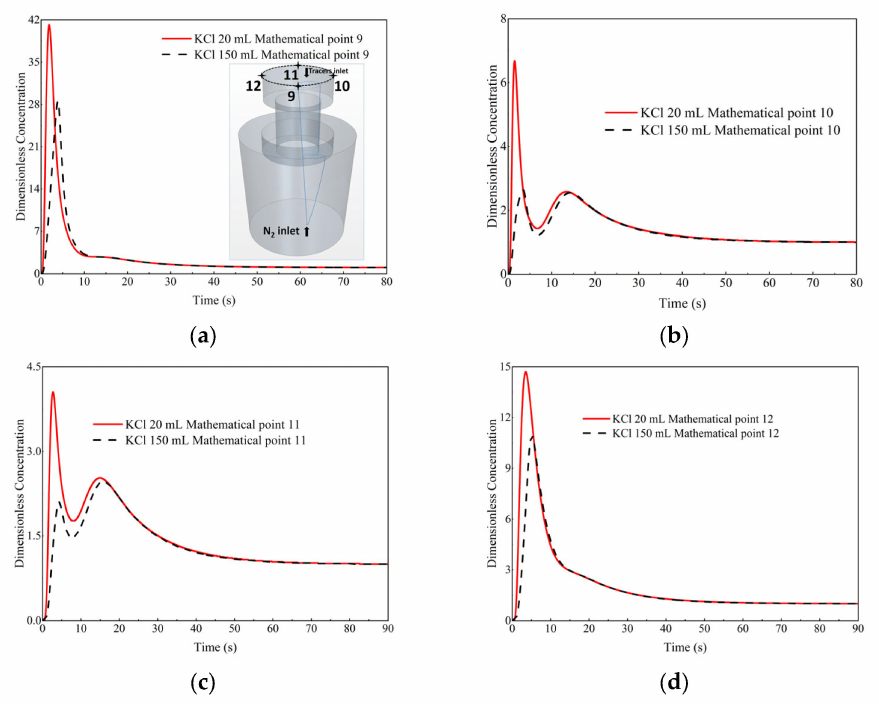
Figure 11. Comparison of the dimensionless concentration-time curves between the case of the 20 mL KCl tracer and the case of 150 mL KCl tracer at different monitor locations. ( a ) Monitor point 9, ( b ) Monitor point 10, ( c ) Monitor point 11, and ( d ) Monitor point